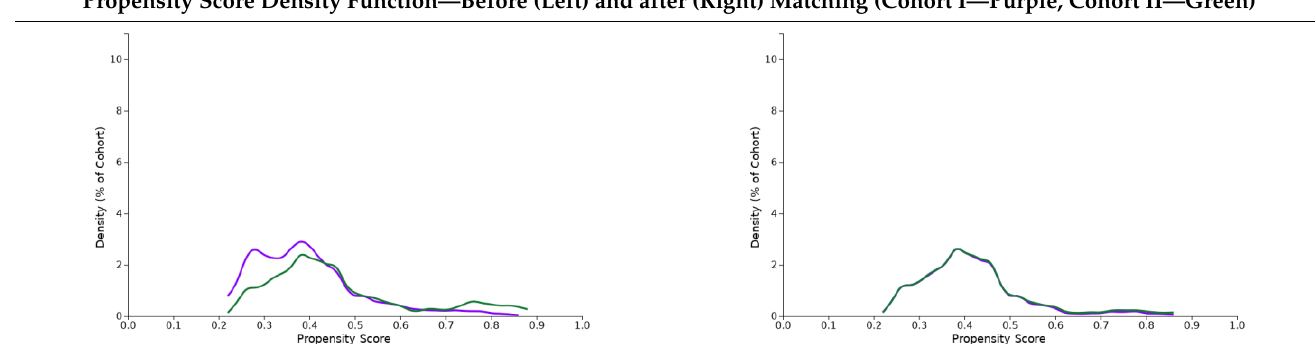
Table 1. Propensity score density function (purple: cohort I, green: cohort II).